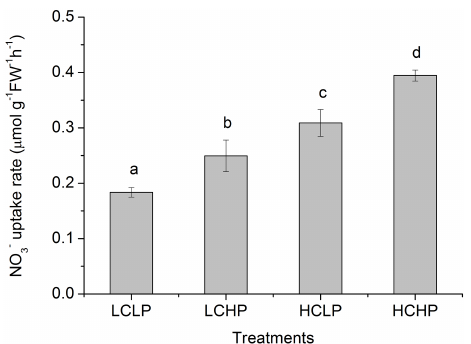
Figure 5. Nitrate uptake rate of S. muticum after being grown at Figure 4. Chl a content of S. muticum after being grown at different different p CO 2 and P conditions for 13 days. Data are reported as p CO 2 and P conditions for 13 days. Data are reported as means ± SD ( n = 3). LCLP is the low p CO means ± SD ( n = 3). LCLP is the low p CO 2 and low P condition, 2 and low P condition, LCHP LCHP is the low p CO 2 and high P condition, HCLP is the high is the low p CO 2 and high P condition, HCLP is the high p CO 2 and p CO 2 and low P condition, and HCHP is the high p CO 2 and high P low P condition, and HCHP is the high p CO 2 and high P condition. condition. Different letters above the error bars indicate significant Different letters above the error bars indicate significant differences differences between treatments ( P < 0 . 05). between treatments ( P < 0 . 05).